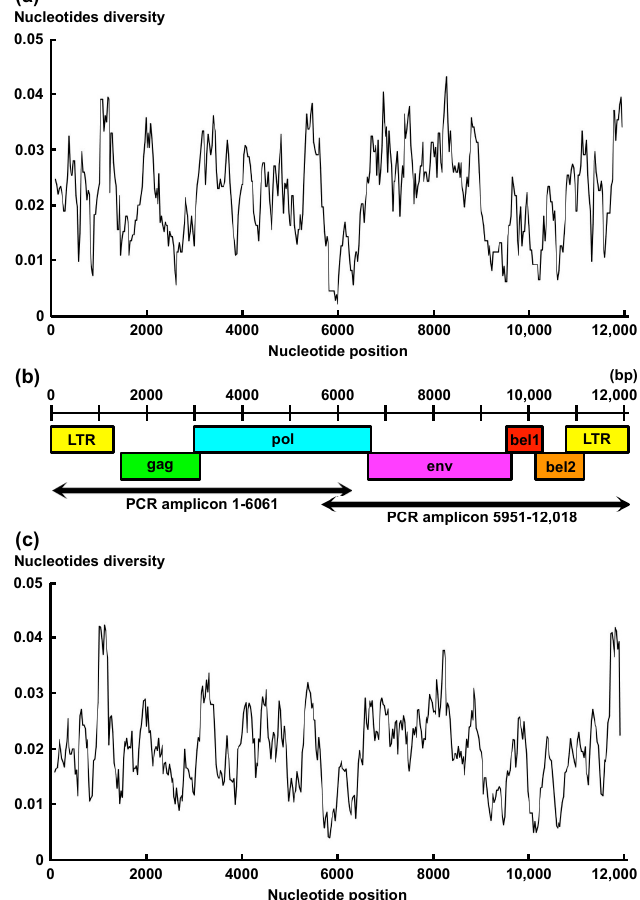
Figure 2. Genome structure and nucleotide diversity of bovine foamy virus (BFV). The nucleotide diversity among the six full-genome sequences of BFVs deposited in GenBank (accession Nos. AY134750, LC510606-7, NC001831, and JX307861-2) is presented. The nucleotide diversity was calculated using DnaSP v6.12 [26]. A sliding window method with windows of 200 nucleotides and steps of 25 nucleotides was used to calculate the nucleotide diversity across the entire alignment ( a ). Genome structure and locations of PCR amplicons for whole-genome analysis are presented. The BFV genome consists of approximately 12,000 nucleotides, including three structural genes ( gag , pol , env ) and two accessory genes ( bel-1 , bel-2 ) flanked by two identical long terminal repeats (LTRs). The locations of the two PCR amplicons for whole-genome analysis are shown ( b ). The nucleotide diversity of full-genome sequences among the 36 BFVs that were obtained in this study and deposited in GenBank is presented ( c ).